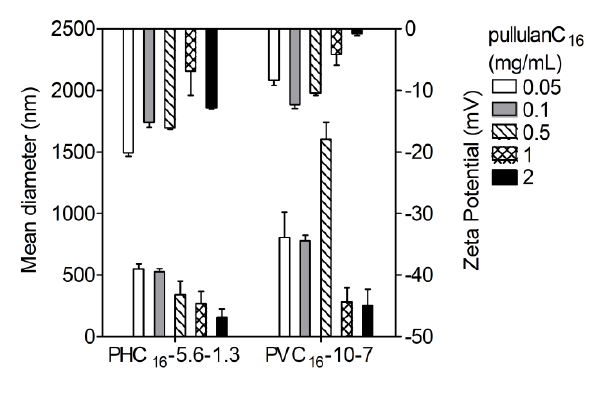
Figure 6. Influence of concentration on the size and zeta potential of pullulan-C (0.05–2 mg/mL) measured at 37 °C in DLS (mean ± S.D., n = 3).